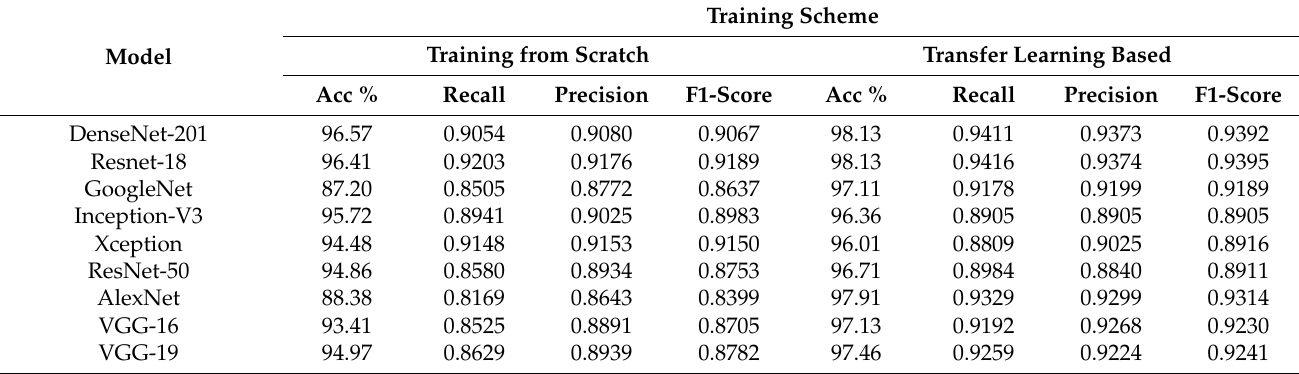
Table 6. Softmax probabilistic-based implementation of customized CNN for malware